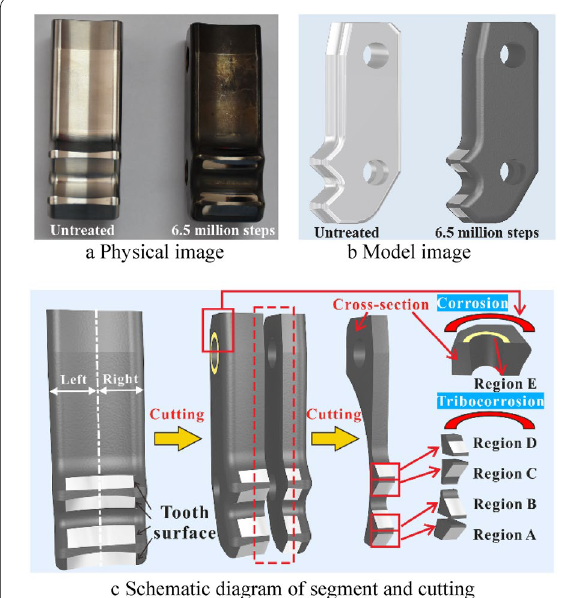
Figure 4 Schematic diagram of degradation mechanism analysis for movable latch